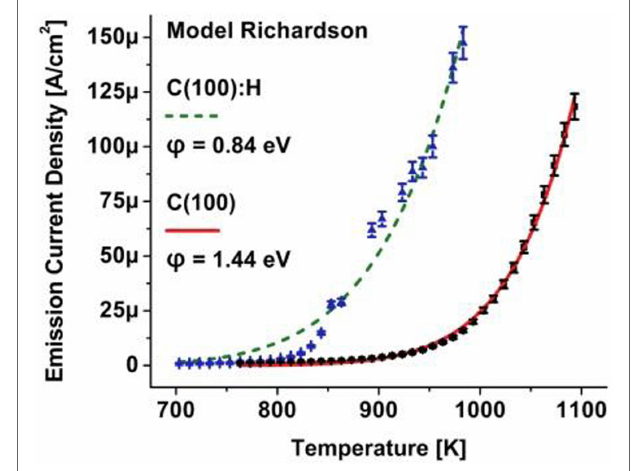
FIGURE 7 | Thermionic electron emission from a phosphorus-doped diamond film with hydrogen passivated surface (triangular data points) with a fit to the Richardson relation (dashed curve) presenting a work function of 0.84eV; the same surface, annealed to desorb hydrogen, exhibits electron emission (square data points) that communicates a work function of